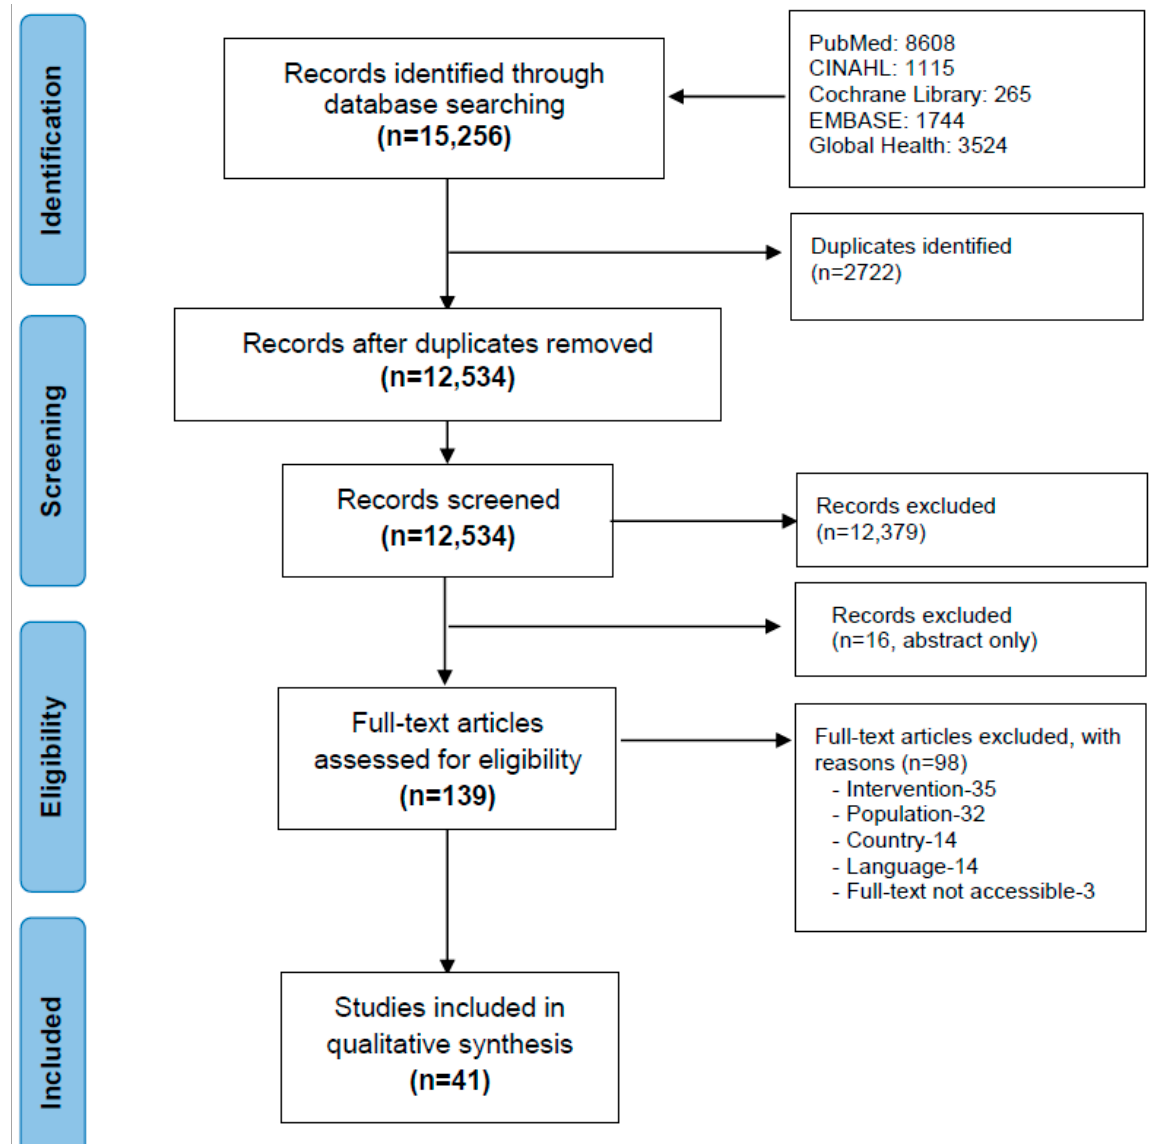
Figure 1. Flow diagram of included and excluded studies.